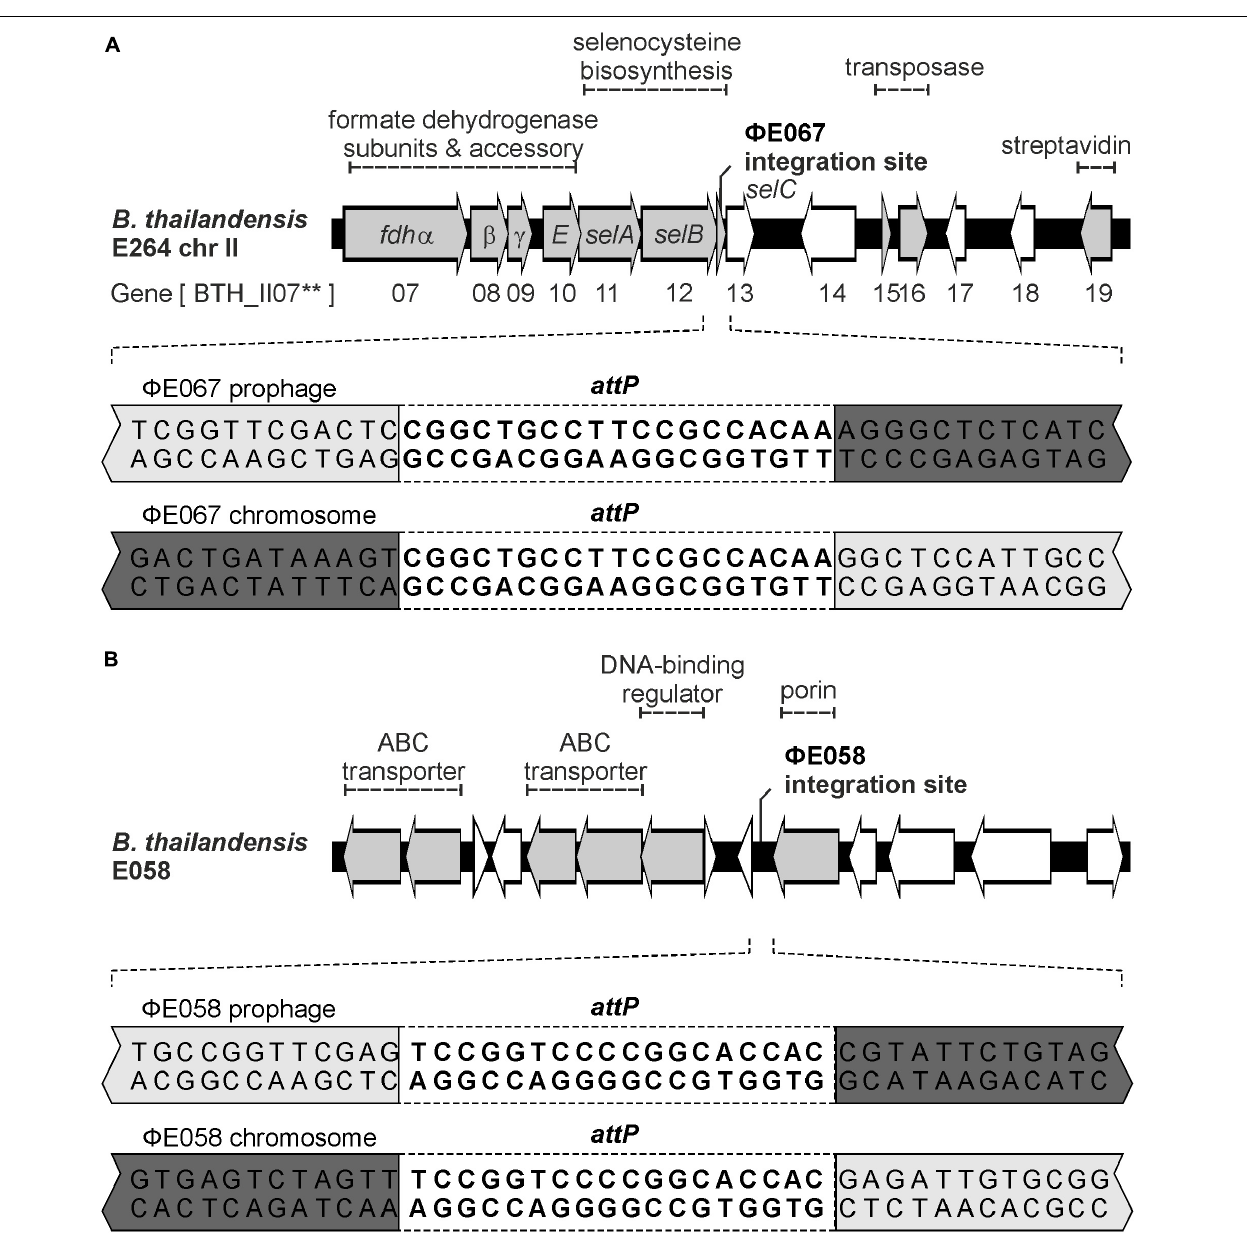
FIGURE 5 | The phages (cid:56) E058 and (cid:56) E067 integrate into the Burkholderia genome at different sites. (A) Integration site of (cid:56) E067. The upper part depicts the region of the Burkholderia chromosome where genes for selenocysteine biosynthesis are located. Phage (cid:56) E067 integrates into the 3 (cid:48) -end of selC . The lower part shows the 19 bp attP site of the phage and the identical site ( attB ) of the host. (B) Integration site of (cid:56) E058. The upper part illustrates the integration region of the B. thailandensis genome E058. The 18 bp attP site of the phage and the identical site ( attB ) of the host are shown.